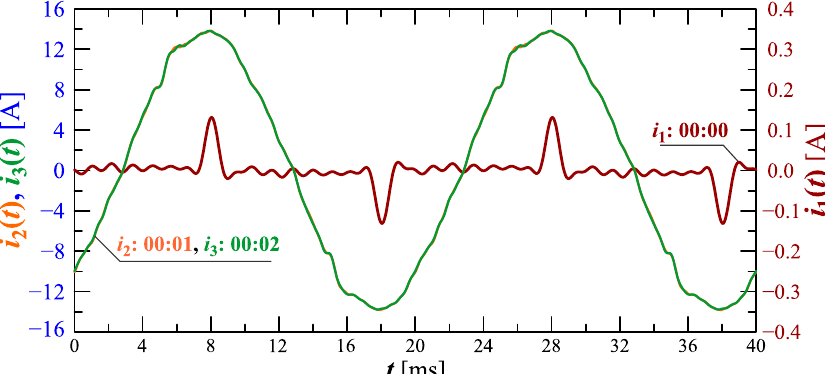
Figure 13. Recreated voltage waveforms u ( t ) and current waveforms i ( t ) recorded at 00:00, 00:01, and 00:02 for Case I.